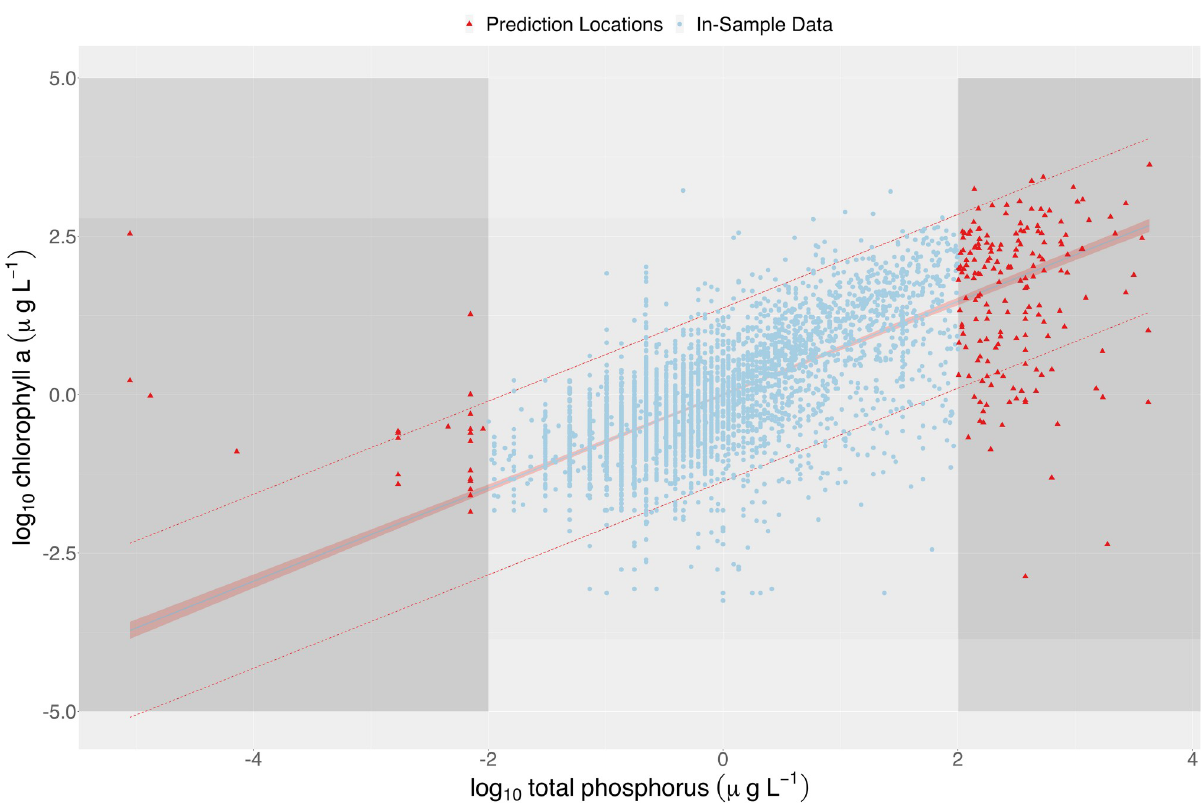
Fig 1. Fit of Chl a–TP relationship for inland lakes using linear regression. A 95% confidence interval of the mean is included around the regression line. Dashed red lines represents the 95% prediction interval. Areas shaded in darker grey indicate regions of extrapolation (using the maximum leverage value ( h ) to identify the ii